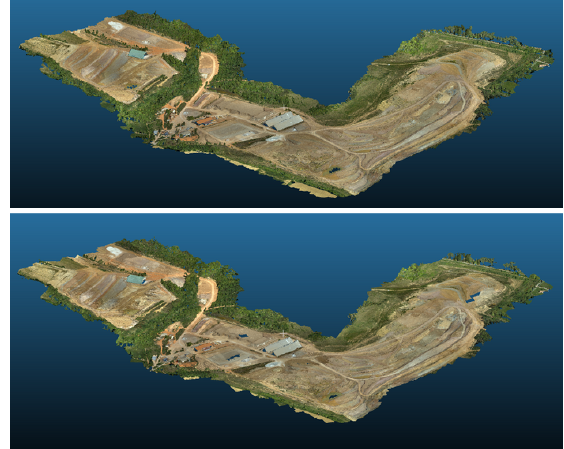
Figure 3. 3D dense point cloud reconstructed by Pix4D (above) anf FORMap (below) from the UX11 dataset.